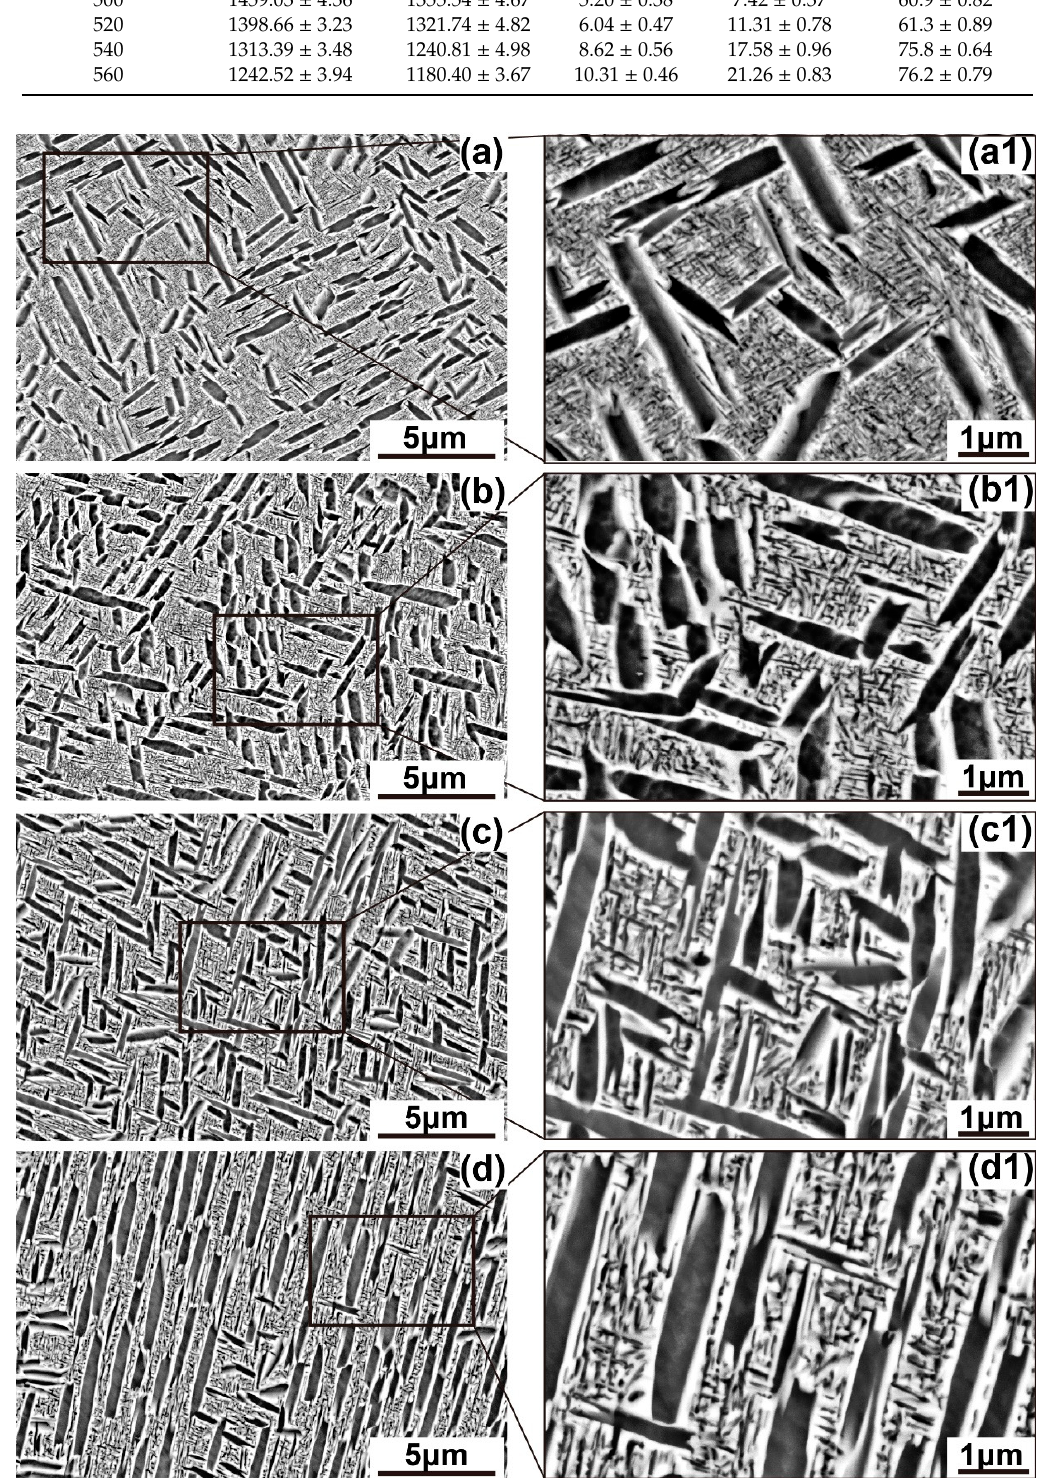
Figure 7. SEM images of bimodal microstructure after aging for 8 h: ( a , a1 ) 500 °C, ( b , b1 ) 520 °C, ( c , c1 ) 540 °C, and ( d , d1 ) 560 °C.